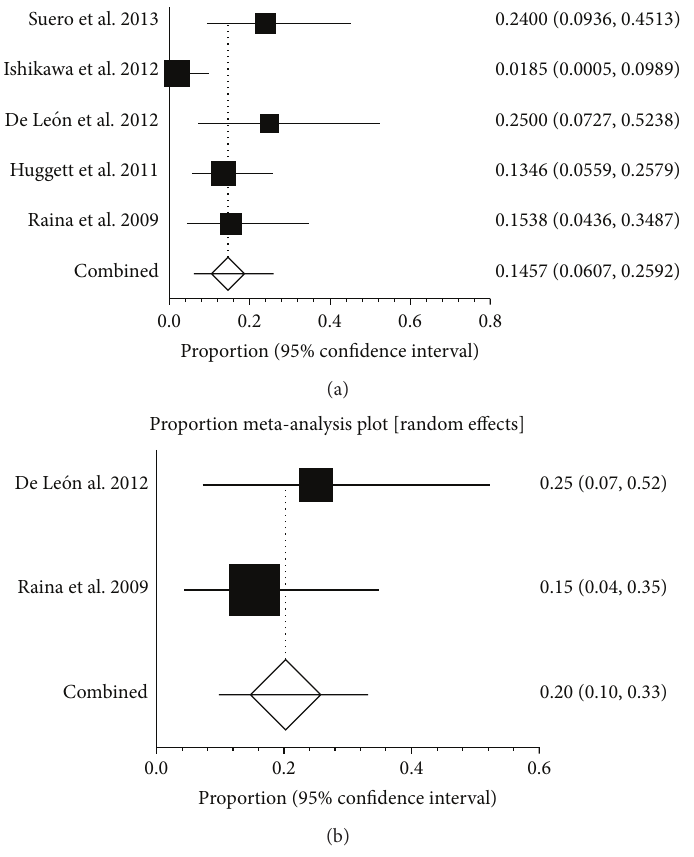
Figure 7: (a) Forest plots showing the prevalence of splanchnic vein thrombosis (SVT) in autoimmune pancreatitis (AIP). (b) Forest plots showing the prevalence of splenic vein thrombosis (SlpVT) in autoimmune pancreatitis